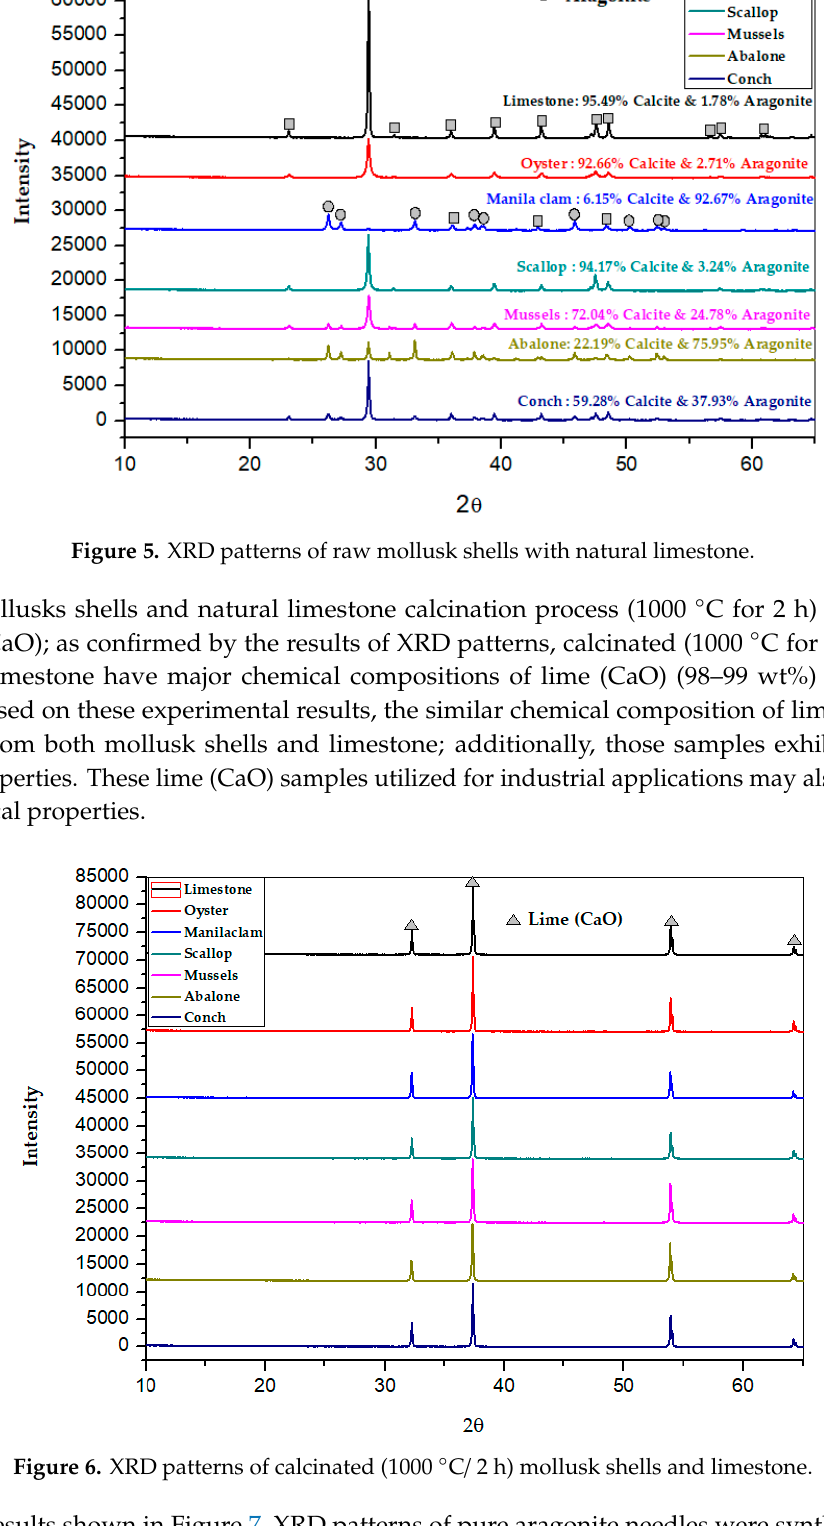
Figure 6. XRD patterns of calcinated (1000 ◦ C / 2 h) mollusk shells and limestone.